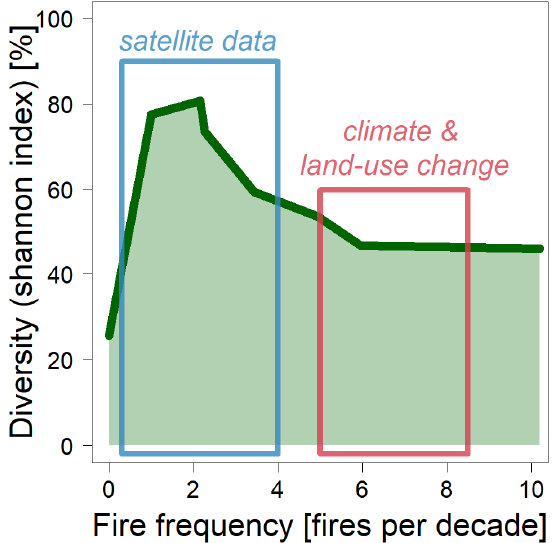
Figure 13. Simulated species diversity for different fire frequencies. In each fire scenario, forest fires